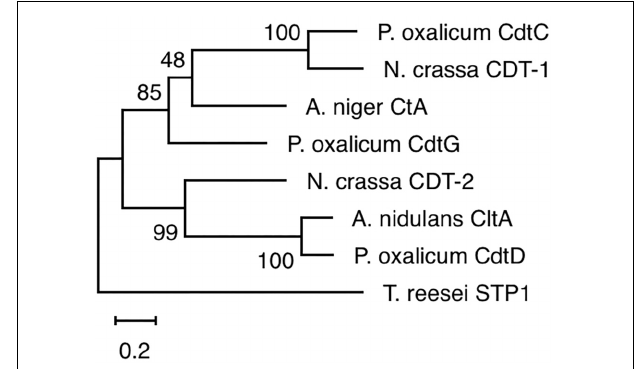
FIGURE 2 | Phylogenetic analysis of CtA and other cellobiose/cellodextrin transporters. Sequence alignments were performed with ClustalX 2.0, and the maximum likelihood tree was generated with Mega X. Numbers on the tree branches represent the bootstrap support calculated per 1000 bootstrap replicates. CdtC, Penicillium oxalicum cellodextrin transporter (GenBank No. EPS25673.1); CDT-1, Neurospora crassa cellodextrin transporter (GenBank No. XP_963801.1); CdtG, Penicillium oxalicum cellodextrin transporter (GenBank No. EPS34431.1); CDT-2, Neurospora crassa cellodextrin transporter (GenBank No. XP_963873.1); CltA, Aspergillus nidulans cellobiose transporter (GenBank No. AN8347); CdtD, Penicillium oxalicum cellodextrin